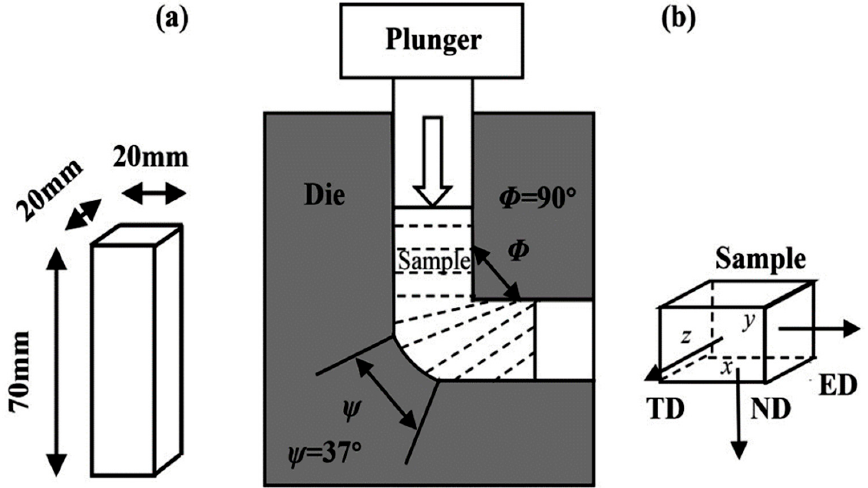
Figure 5. ( a ) The rectangular samples which are prepared for equal-channel angular pressing (ECAP); ( b ) ECAP process with reference axes, ED (extrusion direction), TD (transverse direction) and ND (normal direction) with respect to x-plane [150].